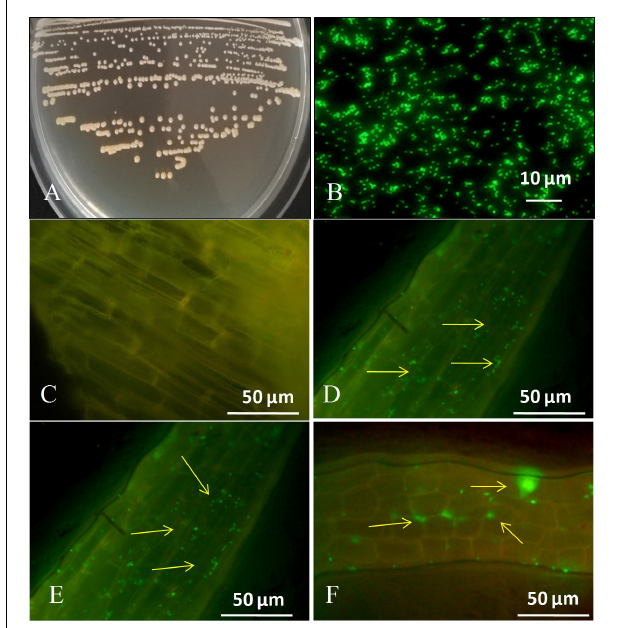
FIGURE 1 | (A) Colony appearance of strain GXS16, (B) Microscopy of GFP-tagged strain GXS16 cells, (C) Non-inoculated plant root (Control), (D) GFP tagged strain GXS16 colonized plant root at 1 day after inoculation, (E) GFP tagged strain colonized root at 3 days after inoculation, (F) GFP tagged strain colonized root at 5 days after inoculation. The presence of bacteria as a single, bunch, or patch is indicated by